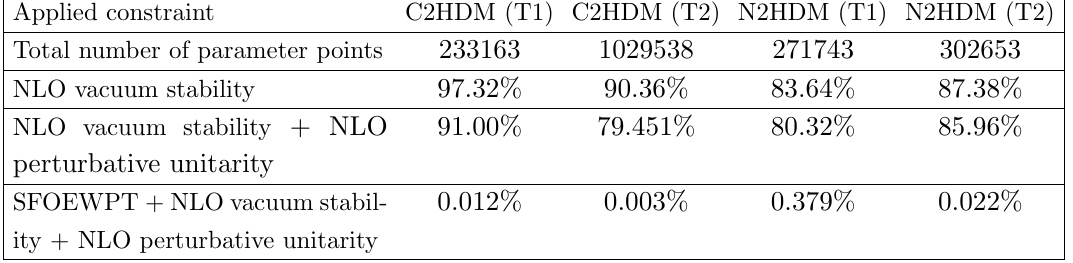
Table 6 . Reduction of the number of parameter points before and after applying NLO vacuum stability, NLO perturbative unitarity and an